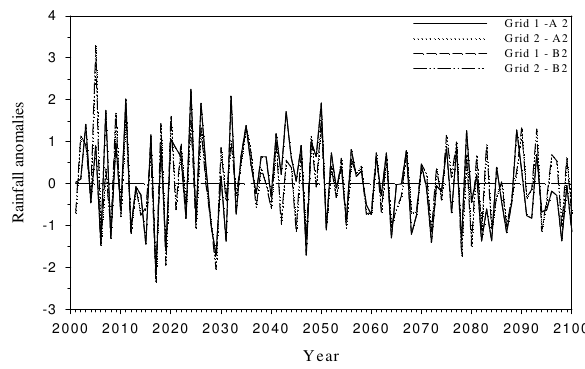
Fig. 3. Annual variability of the standardized rainfall anomalies for 100 years (2000–2100), [(ECHAM4 simulated – mean)/standard deviation].